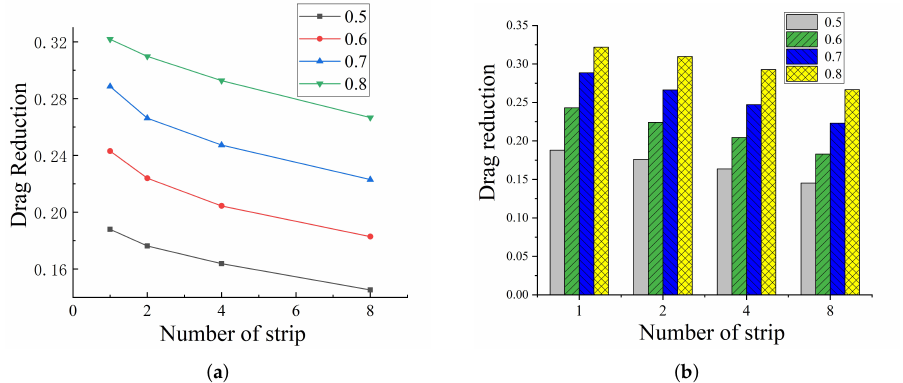
Figure 17. Drag reduction effect of superhydrophobic surfaces at different scenarios. ( GF = 0.5,0.6,0.7,0.8. Strip number = 1,2,4,8).